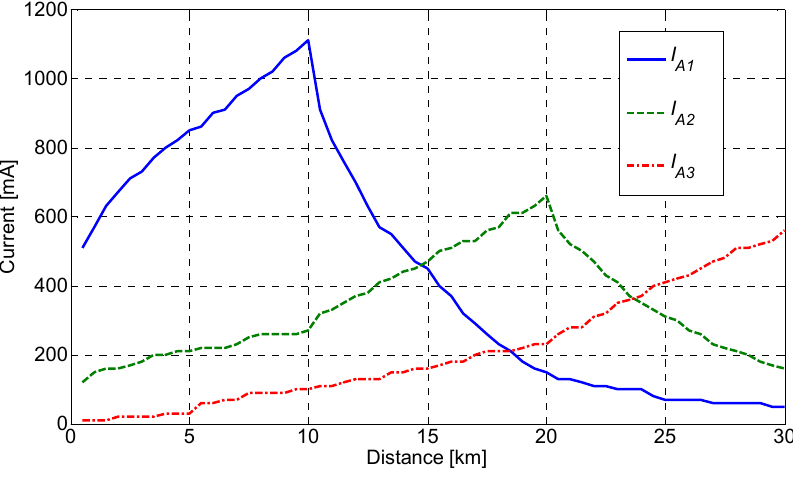
Figure 16. Autotransformers current distribution in the tests with a fault between the feeder and rail.